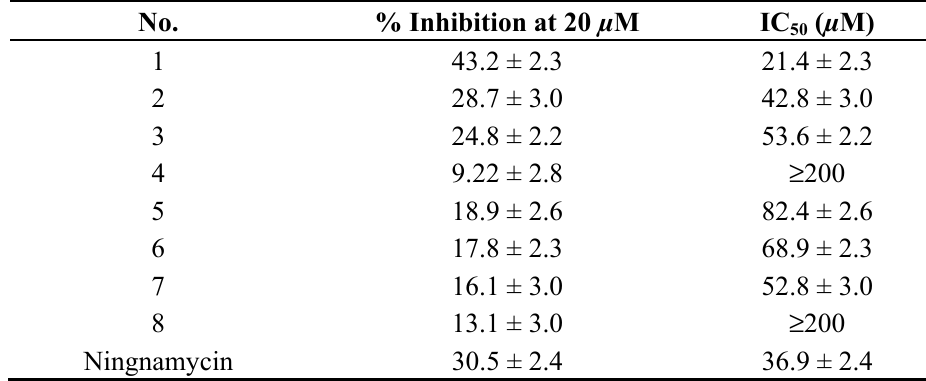
Table 2. Anti-TMV Activity of 1 – 7 on Garcinia paucinervis Leaf a